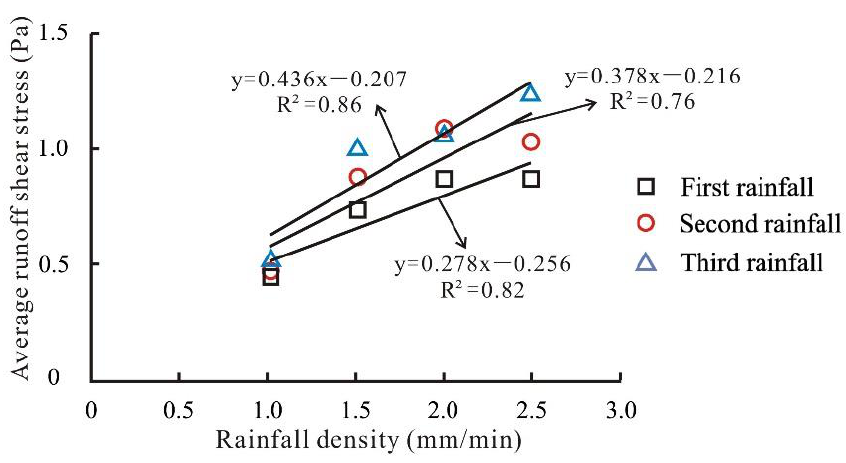
Table 6. Average downslope runoff power with different rainfall density and times.